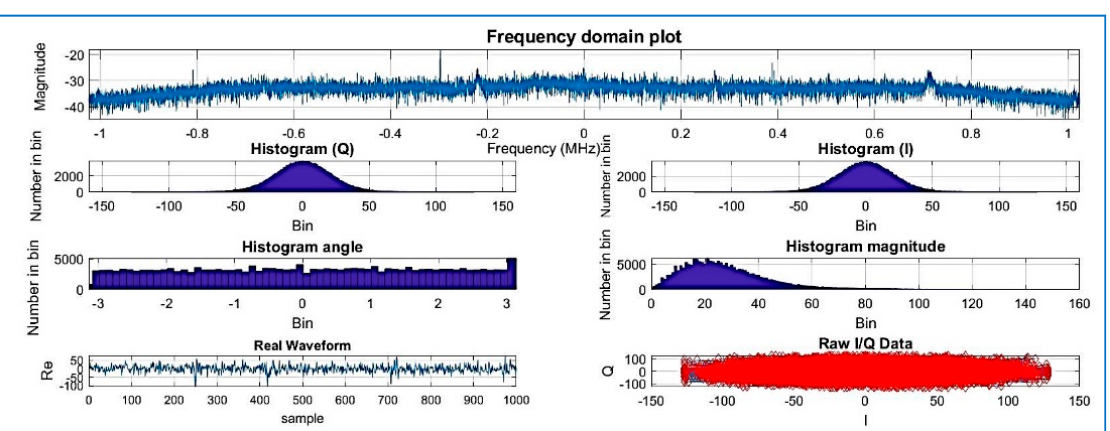
Figure 14. Recorded real signal Dataset 2: ( a ) the correlation peak; and ( b ) the correlation peak of the GPS signal when the signal is compressed with R = 0.03.